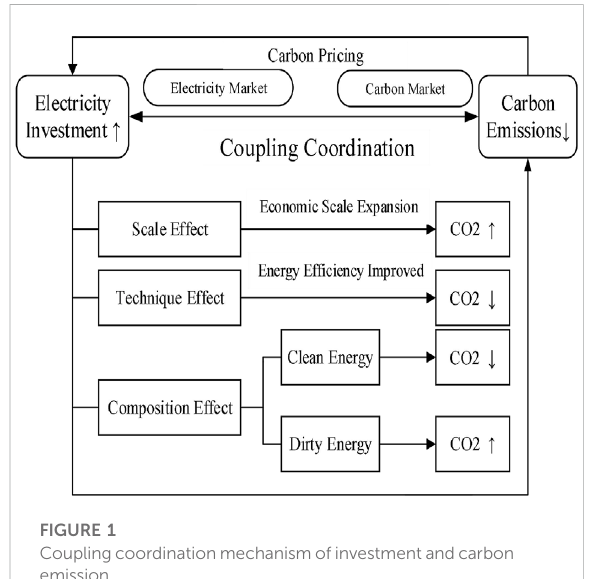
FIGURE 1 Couplingcoordinationmechanism ofinvestmentandcarbon